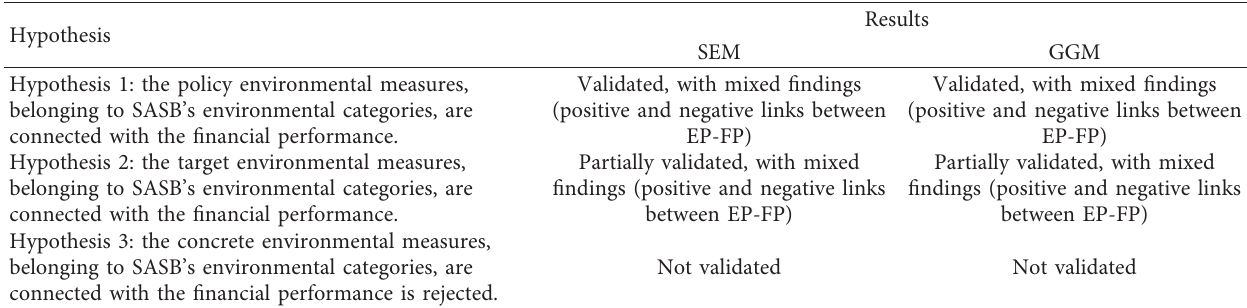
Table 3: Summary of the hypotheses and their